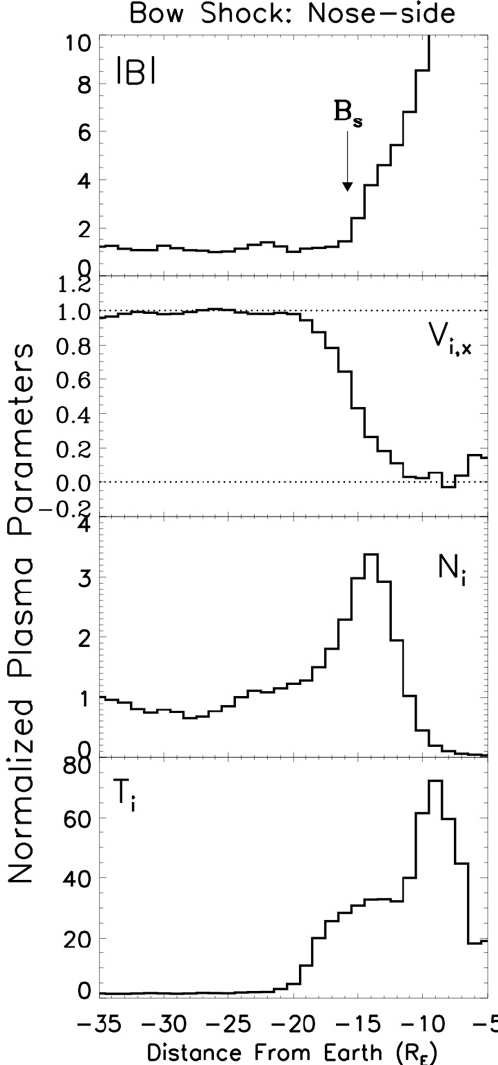
Fig. 2. Normalized plasma parameters drawn within the gap. This figure is plotted in 100-step time, soon after the disturbance is ap- plied to the system. In five panels the solar parameters are shown in the following order, speed, number density, temperature, mag- netic field strength and total pressure. The x-axis is reversed time